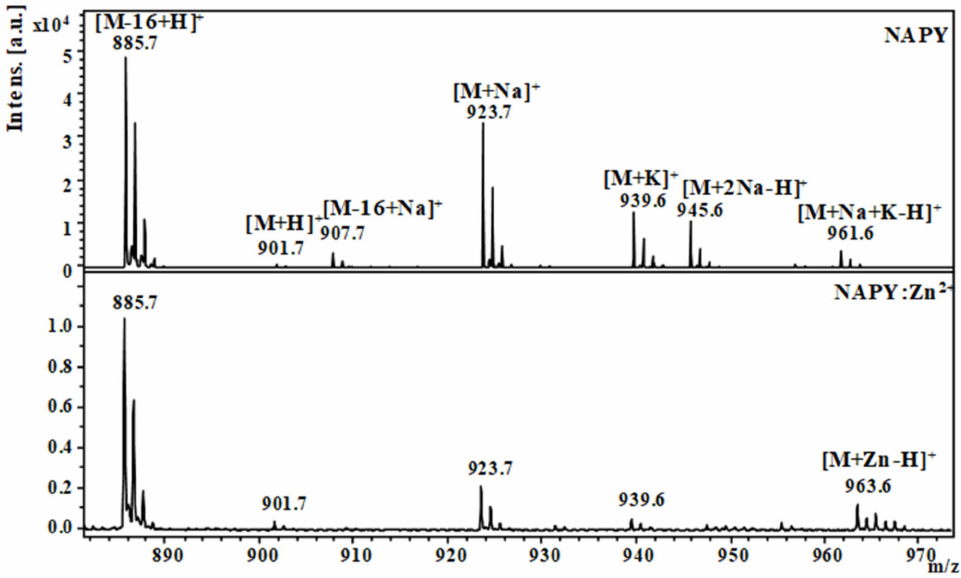
Figure 2. MALDI ToF MS spectra of the tyrosine-modified NAPY peptide in the presence and absence of zinc ions at a 1:10 peptide to metal